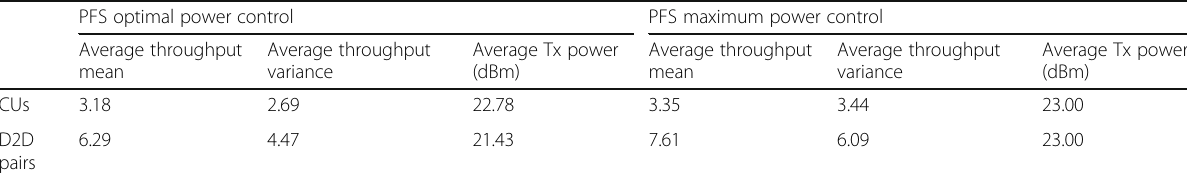
Table 3 Numerical analysis for PFS with different power control methods PFS optimal power